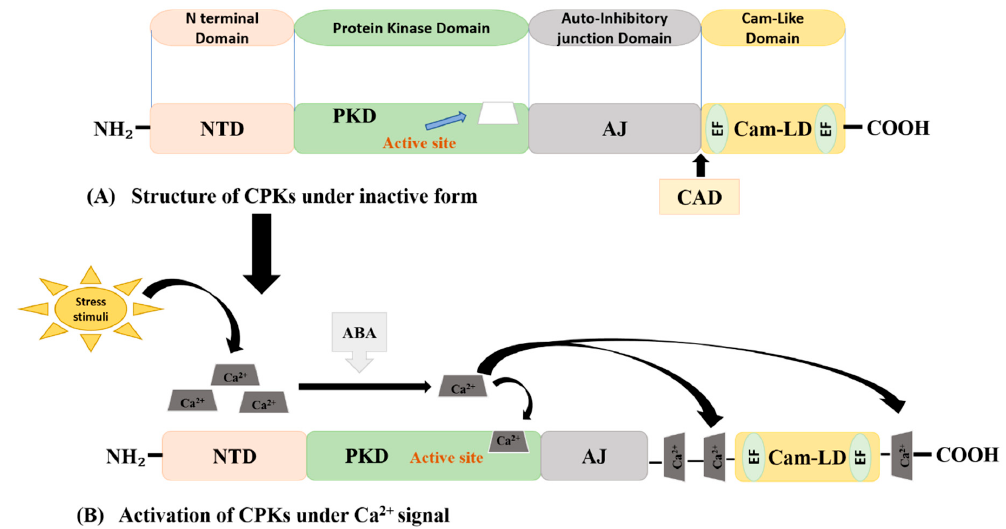
Figure 1. Structure and activation process of plant CPKs. ( A ) CPK domain structure under the inactive state, ( B ) activation of CPKs after the binding of Ca 2+ to the active site of the protein kinase domain (PKD), the autoinhibitory junction (AJ), and calmodulin-like domain (CaM-like domain, CaM-LD). CPKs are monomolecular Ca-signaling protein kinases that regulate protein phosphorylation.